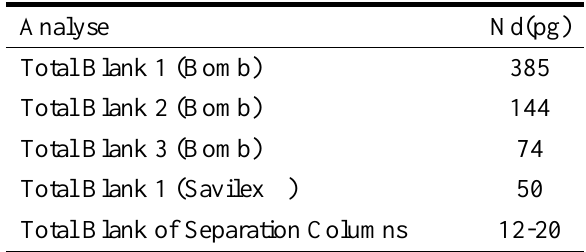
Experimental blank data for Nd in the